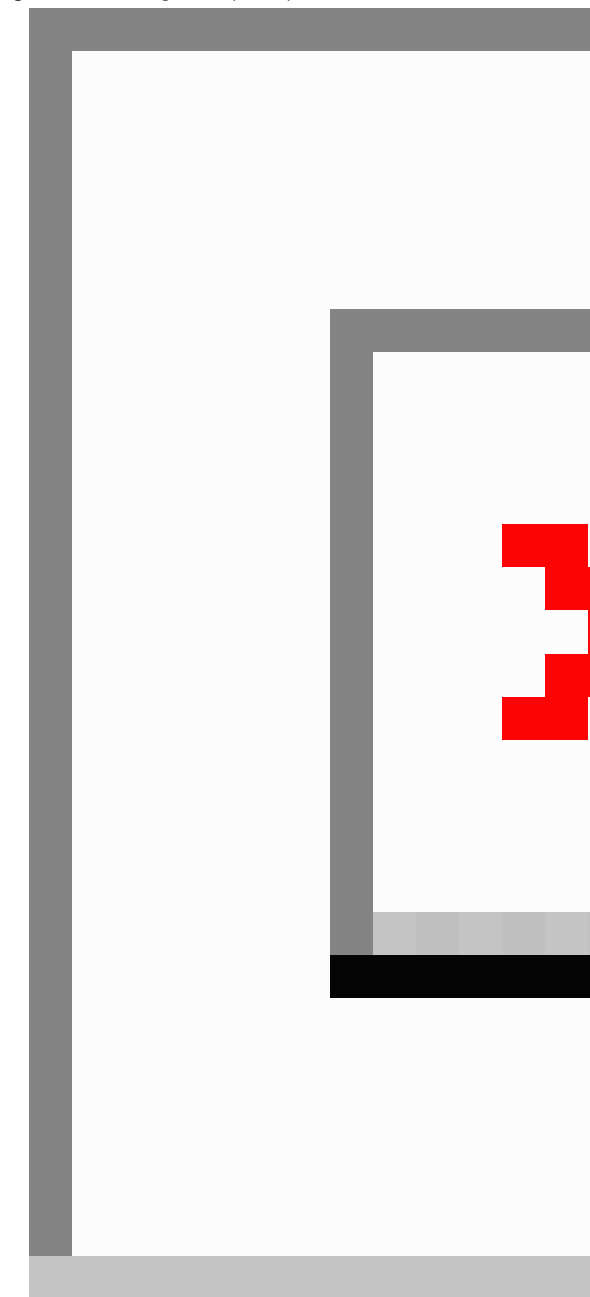
Figure 1. Flow diagram of